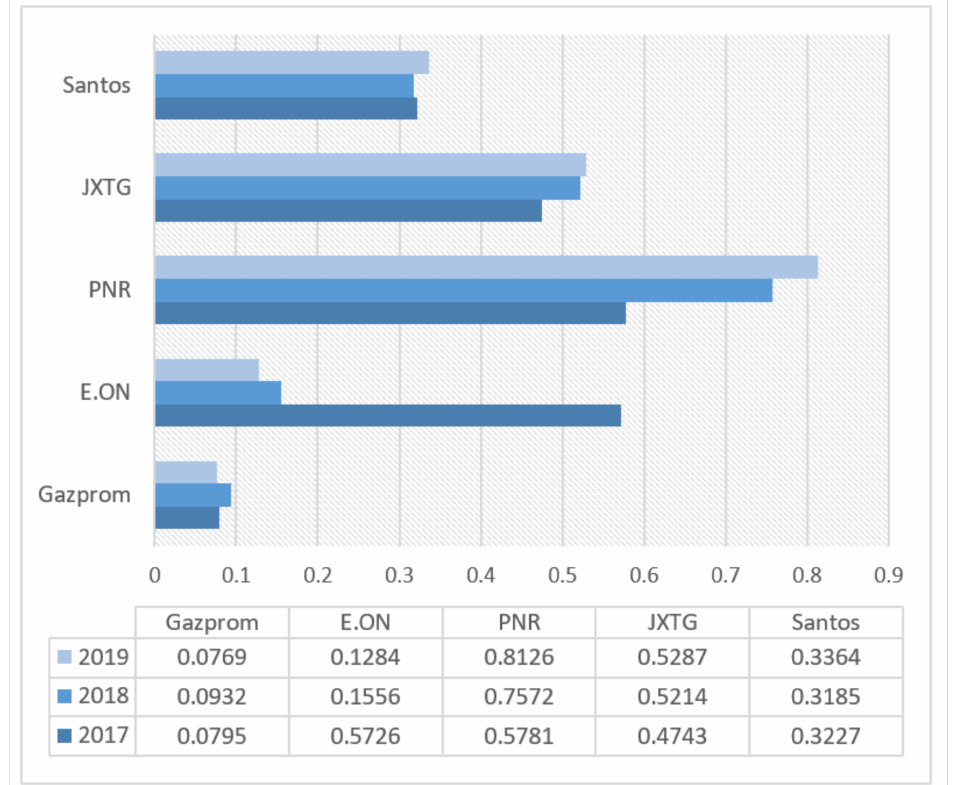
Figure 3. Integrated indicators for assessing the performance of companies taking into account the social aspects of development (corporate social responsibility) ( FA csr ) . Source: compiled by the authors based on the materials of the surveyed